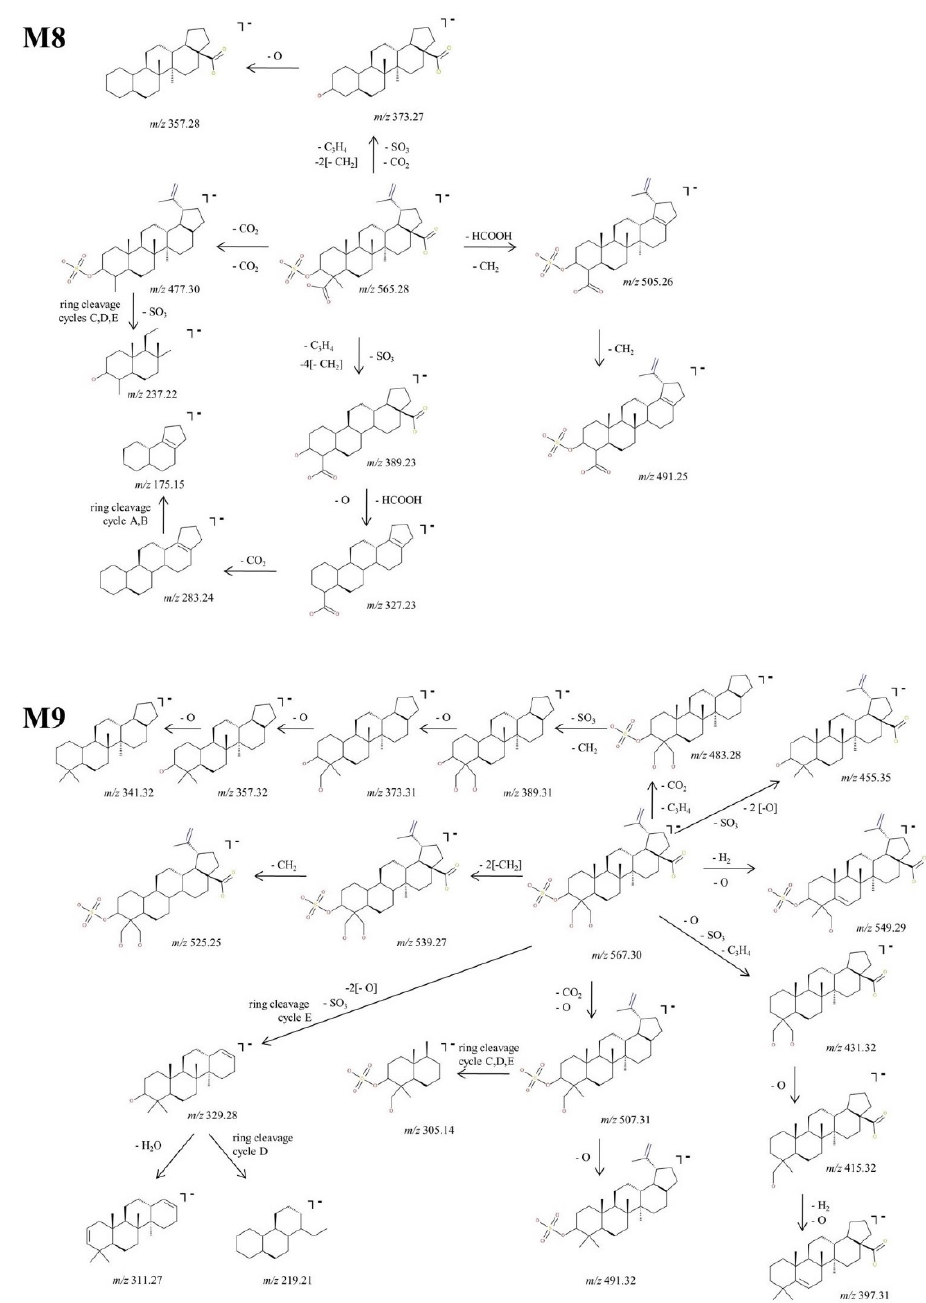
Figure 8. Proposed fragmentation pathway for phase II metabolites: M8–M9.